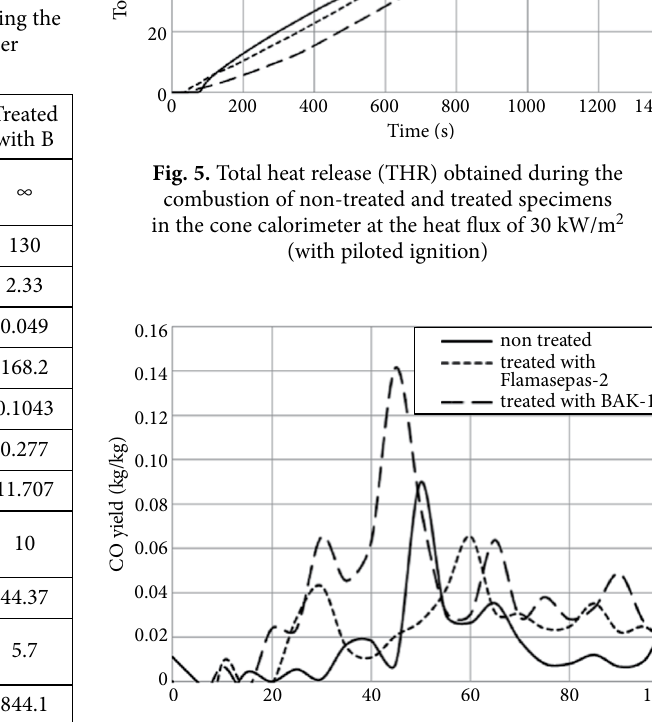
Fig. 6. A peak of CO yield obtained during the first stage of combustion (time interval: 0–100 s) of non-treated and treated specimens in the cone calorimeter at the heat flux of 30 kW/m 2 (with piloted